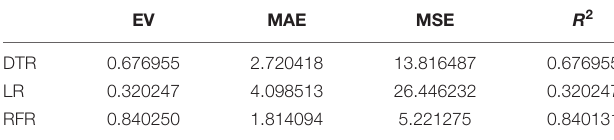
FIGURE 6 | Comparison of agreeableness-predicted value.